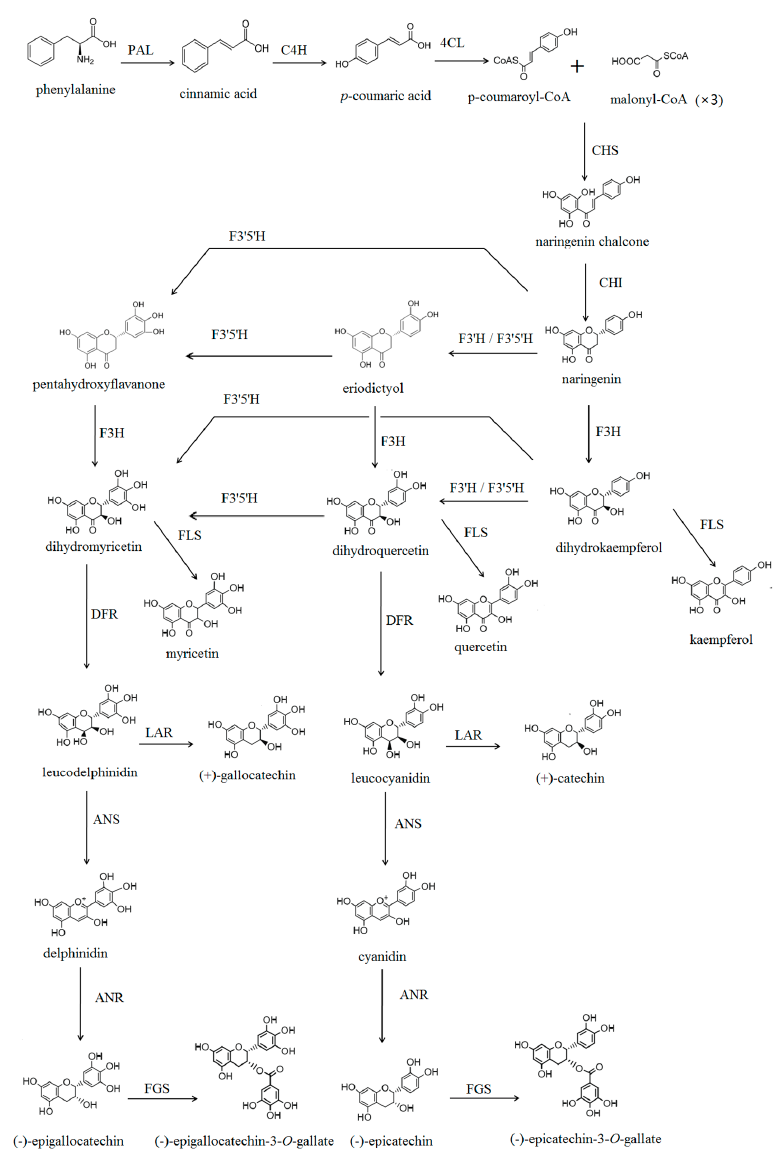
Figure 1. Suggested biosynthetic pathways of flavan 3-ols in Camellia sinensis leaves. Abbreviations of enzymes are as follows: PAL, phenylalanine ammonia-lyase (EC 4.3.1.24); C4H, cinnamic acid 4-hydroxylase (EC 1.14.13.11); 4CL, 4-coumarate-CoA ligase (EC 6.2.1.12); CHS, chalcone synthase (EC 2.3.1.74); CHI, chalcone isomerase (EC 5.5.1.6); F3H, flavanone 3-hydroxylase (EC 1.14.11.9); F3 ′ ,5 ′ H, flavonoid 3 ′ ,5 ′ -hydroxylase (EC 1.14.13.88); F3 ′ H, flavonoid 3 ′ -hydroxylase (EC 1.14.13.21); FLS, flavonol synthase (EC 1.14.11.23); DFR, dihydroflavanol 4-reductase (EC 1.1.1.219); ANS, anthocyanidin synthase (EC 1.14.11.19); ANR, anthocyanidin reductase (EC 1.3.1.77); LAR, leucocyanidin reductase (EC 1.17.1.3); FGS, flavan 3-ol gallate synthase (EC number not assigned). Five well characterized F3 ′ Hs from other plant species, MdF3 ′ H from Malus × domestica (GenBank ID: ACR14867.1) [29], PhF3 ′ H from Petunia hybrida (GenBank ID: AAD56282.1) [17],